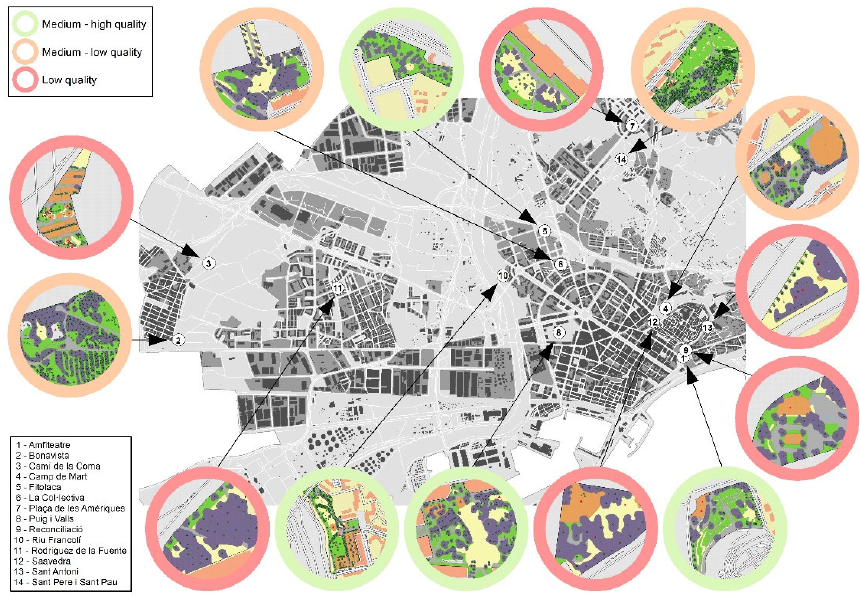
Figure 6. Location and quality level of the urban parks in Tarragona. Source: own work.